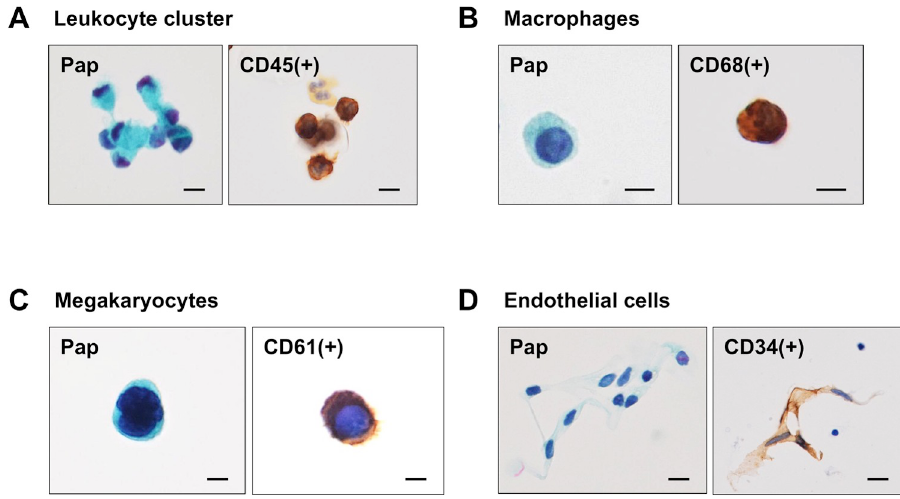
Fig 4. Differentiation of CTCs from circulating non-neoplastic cells in DVB and PB from CRC patients. (A) Leukocyte cluster stained for Pap/CD45 and a macrophage stained for Pap/CD68. (B) Circulating megakaryocytes in PB stained for Pap/CD61, showing multinucleated giant cell morphology. (C) Circulating endothelial cells in DVB stained for Pap/CD34, showing cell cluster formation. Bar = 10 μ m.